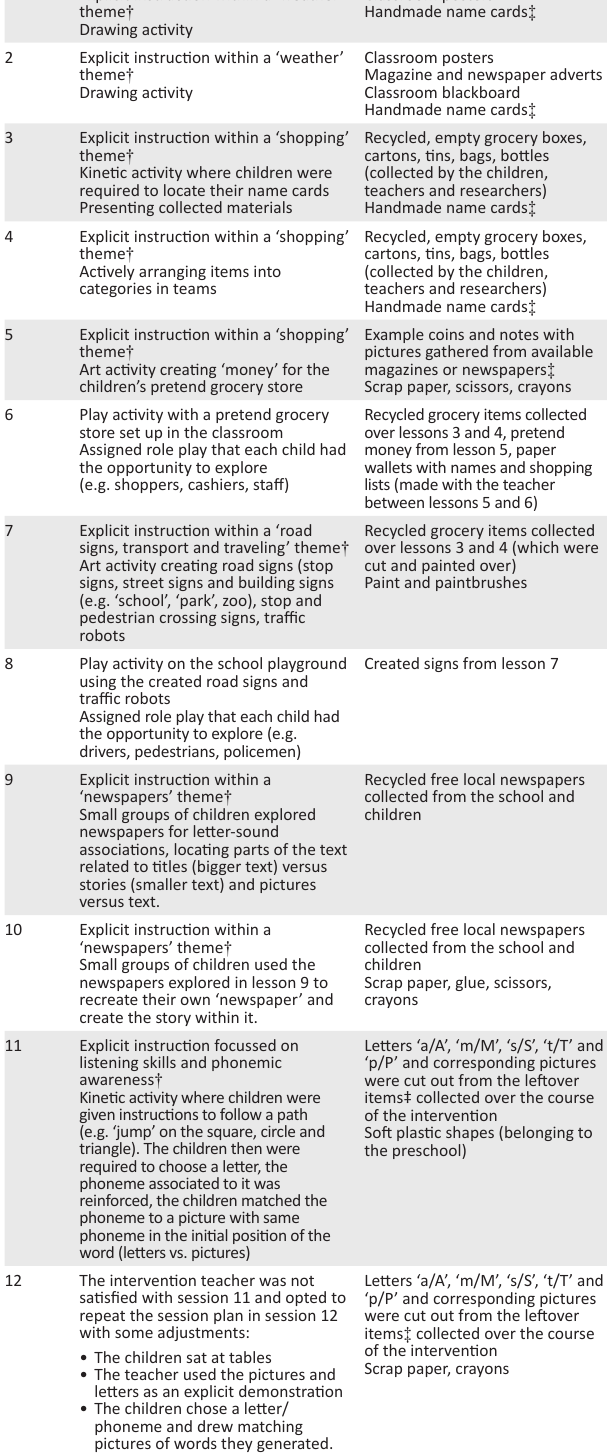
TABLE 4: Concepts About Print t -test p values (Intervention and Comparison Groups). Intervention